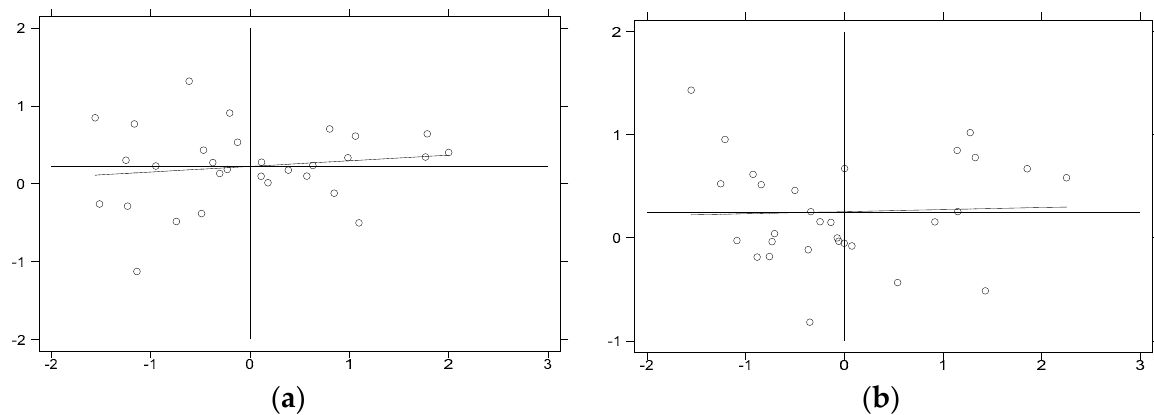
Figure 4. Local Moran’s I scatter plot of environmental pollution. ( a ) Year of 2003. ( b ) Year of 2016. Note: The top left corner of the image is the first quadrant, then counterclockwise in order, the second, third and fourth quadrants.